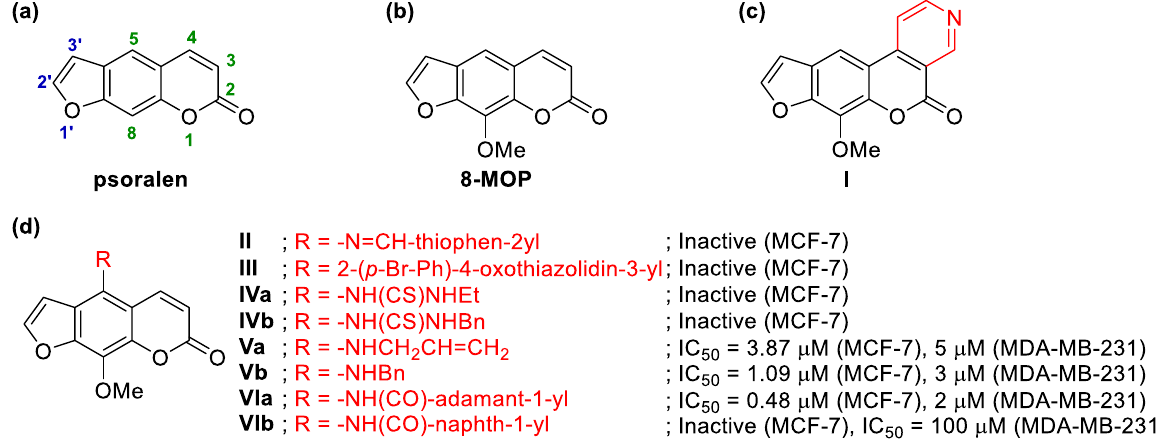
Figure 1. Example of psoralen derivatives and their anti-cancer